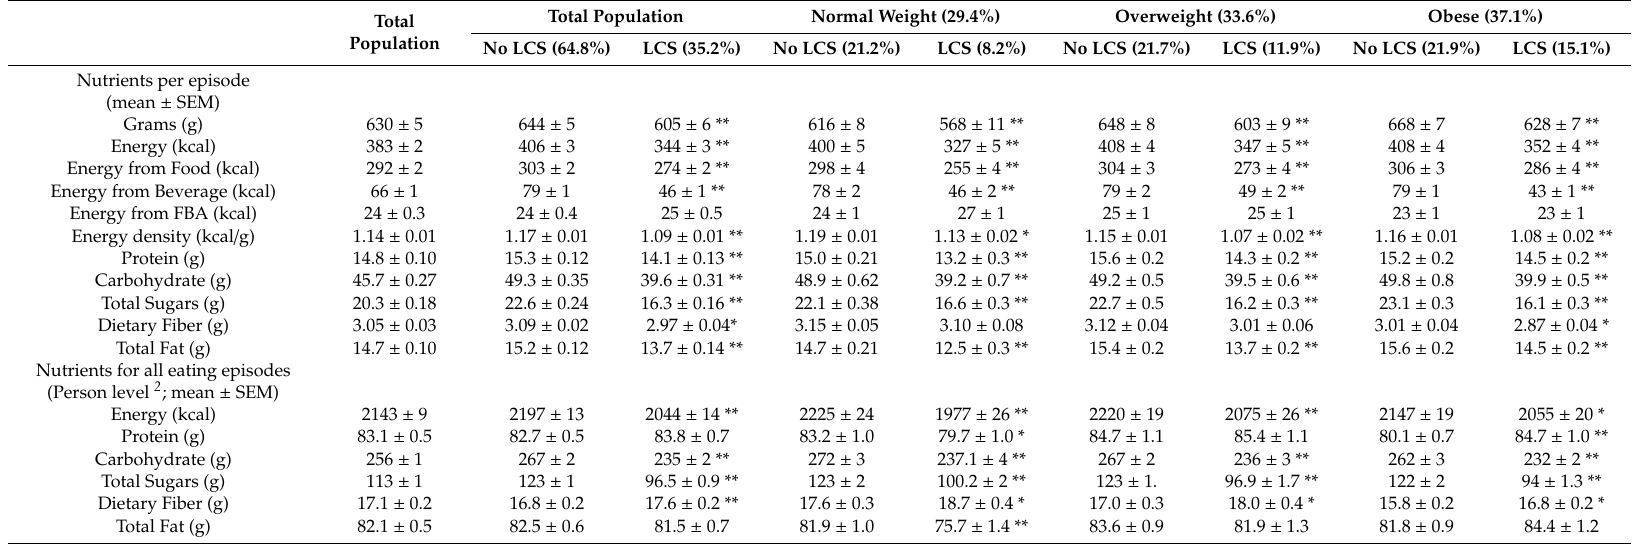
Table 2. Nutrients per eating episode 1 and for all eating episodes 2 (i.e., at the person level) across the day in US adults aged ≥ 19 y by LCS intake and BMI category (NHANES 2007–2016). 3